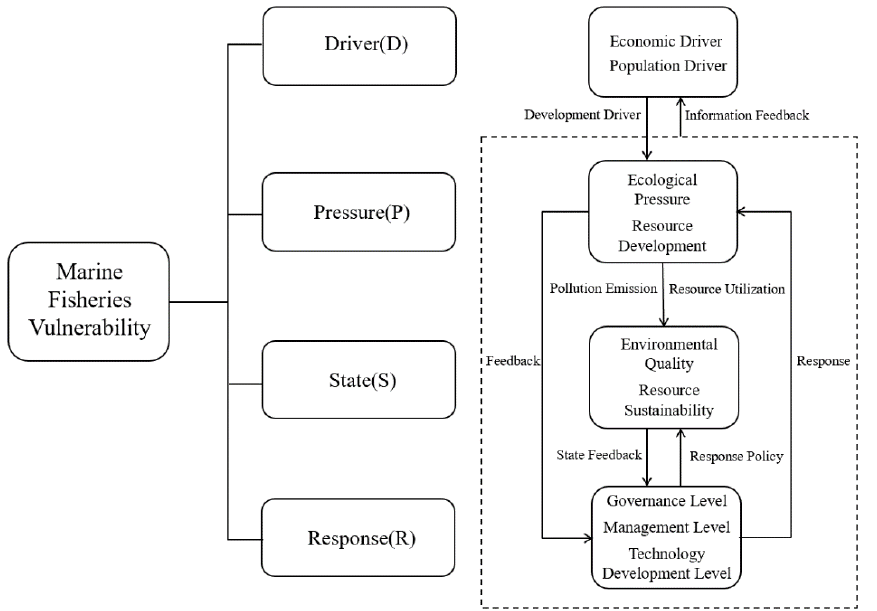
Figure 1. Conceptual framework for the vulnerability evaluation index system. Table 1. Vulnerability evaluation indicator system for China’s marine